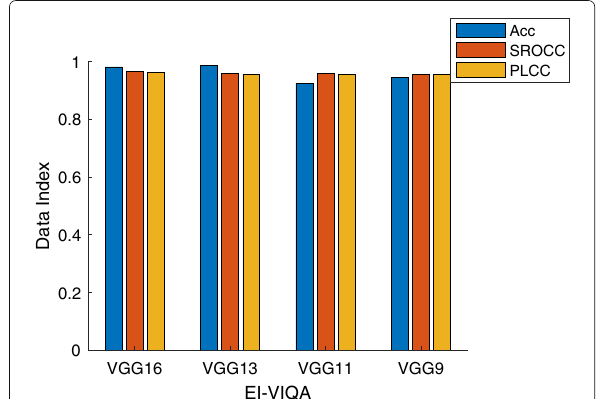
Fig. 6 Comparison histogram of ResNet degrading results in